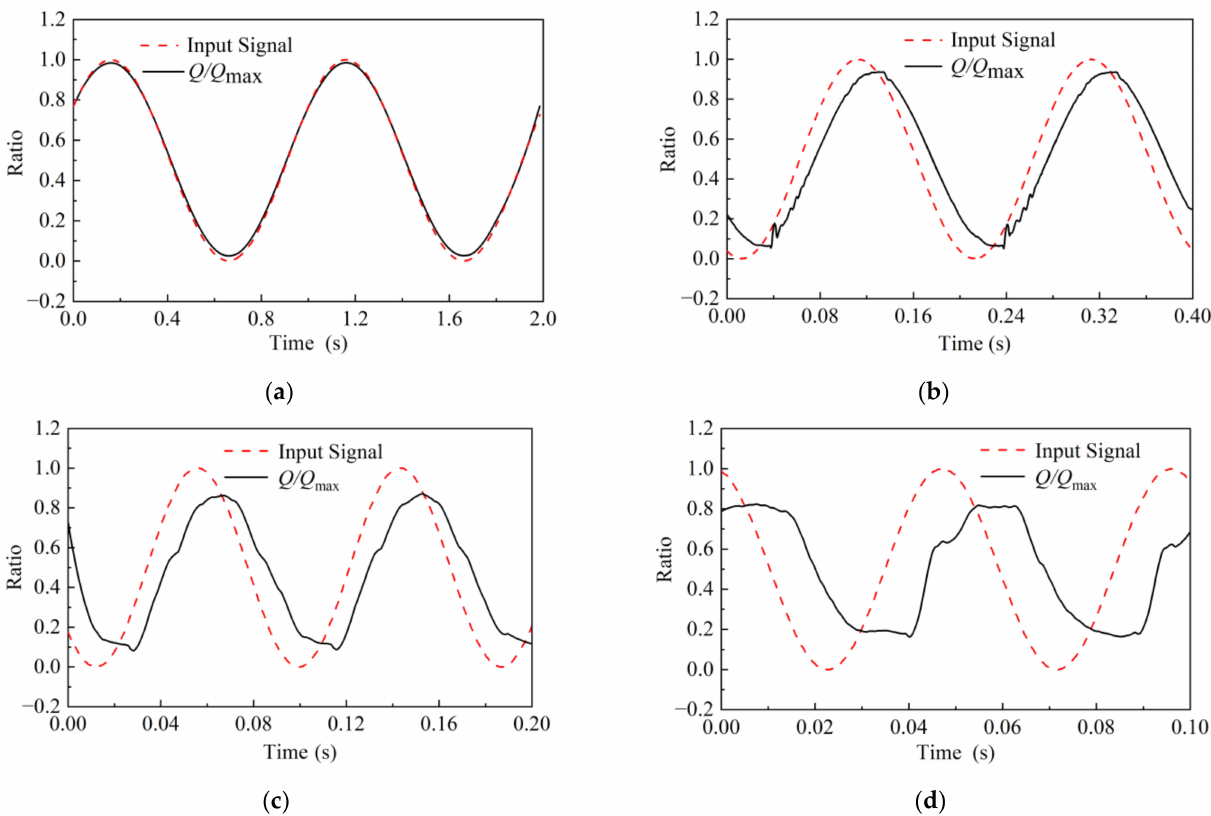
Figure 20. Flow-following curves at different frequencies. ( a ) Flow-following curve at an input signal frequency of 1 Hz; ( b ) flow-following curve at an input signal frequency of 5 Hz; ( c ) flow-following curve at an input signal frequency of 10 Hz; ( d ) flow-following curve at an input signal frequency of 20